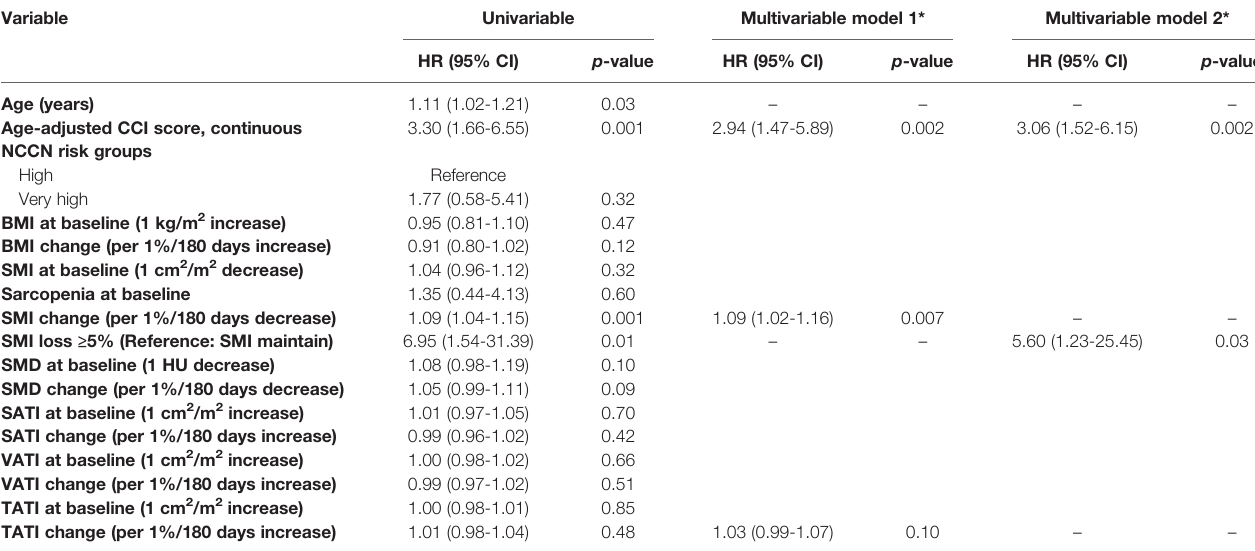
TABLE 3 | Cox proportional hazards model for non-cancer